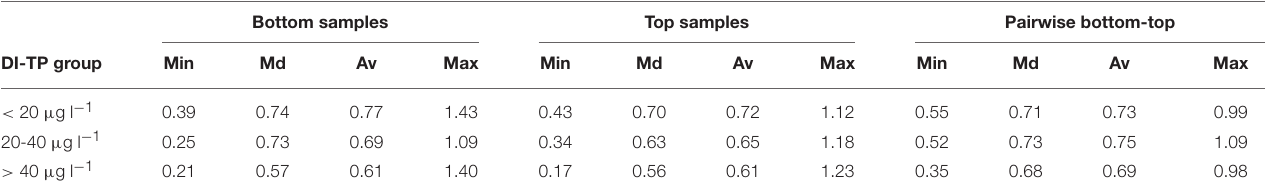
TABLE 2 | Minimum (Min), median (Md), average (Av), and maximum (Max) values for squared chord distances (SCDs) between all bottom diatom samples, all top samples, and the bottom-top sample pairs in three groups along the natural phosphorus gradient (pre-human disturbance diatom-inferred total phosphorus, DI-TP; Lake Suo-Valkeinen #42 excluded). Bottom samples Top